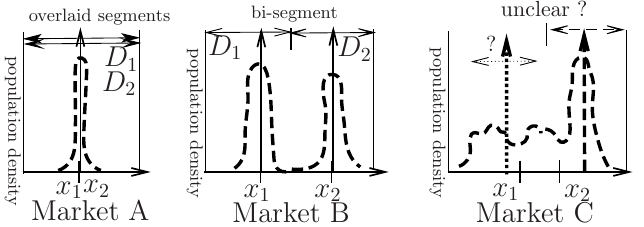
Figure 1. Intuition on the influence of consumer preference distribution on the differentiation